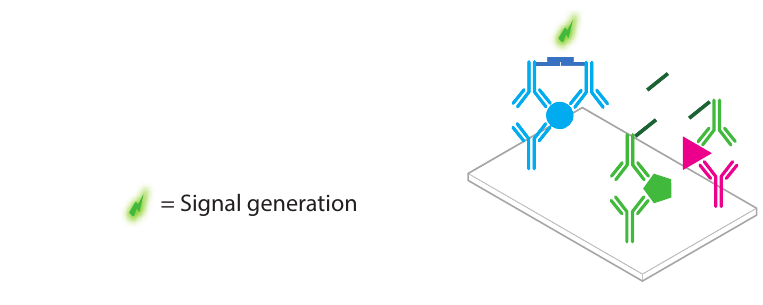
Figure 10. The proximity ligation assay is specifically designed to suppress cross-talk and matrix effects in IPCR.